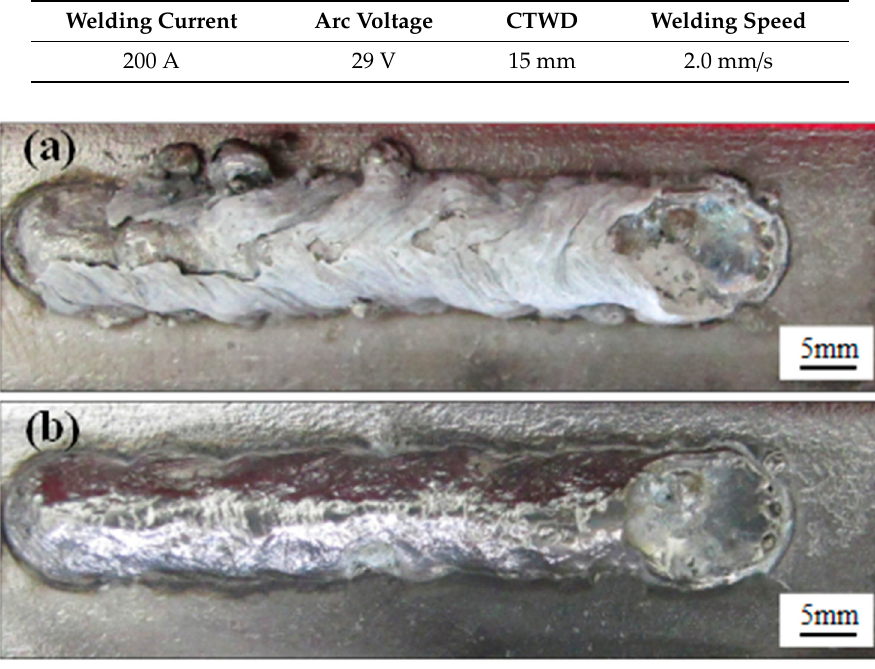
Figure 8. Weld macroscopic morphology. ( a ) before the deslagging; ( b ) after the deslagging.